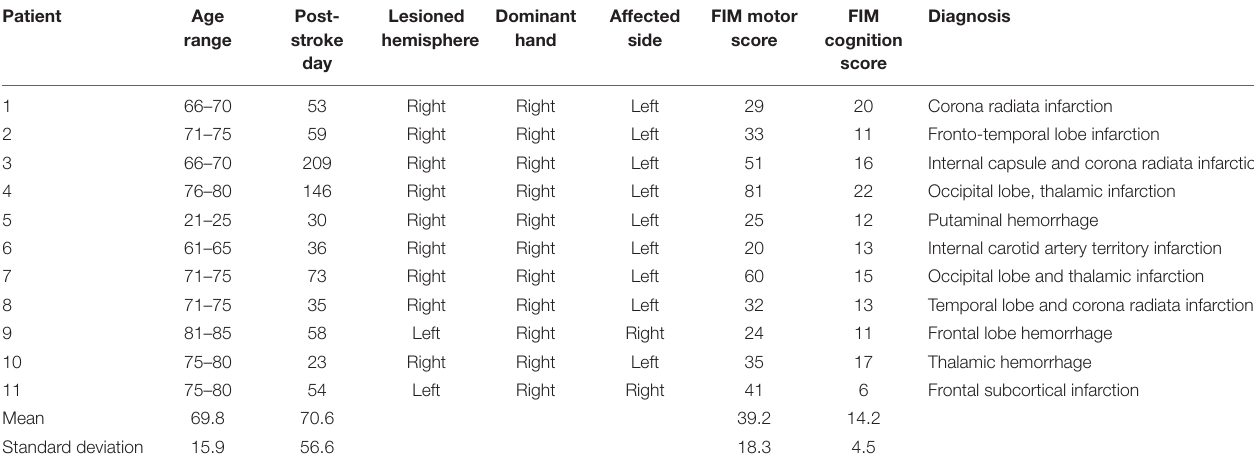
TABLE 1 | Description of the participants in the constructional apraxia group.